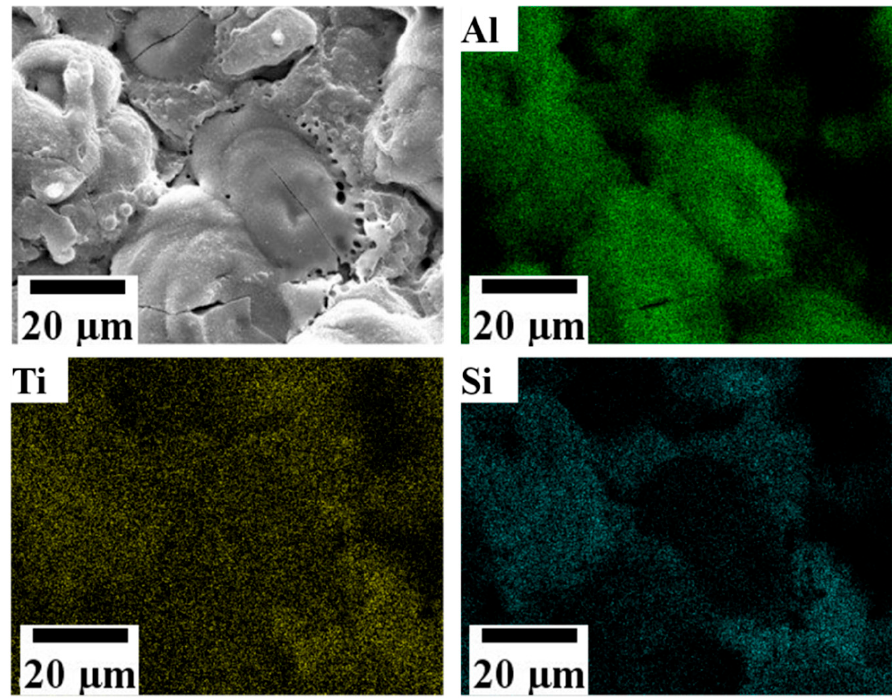
Figure 4. SEM image and elemental map on the surface of S3K1 specimen.